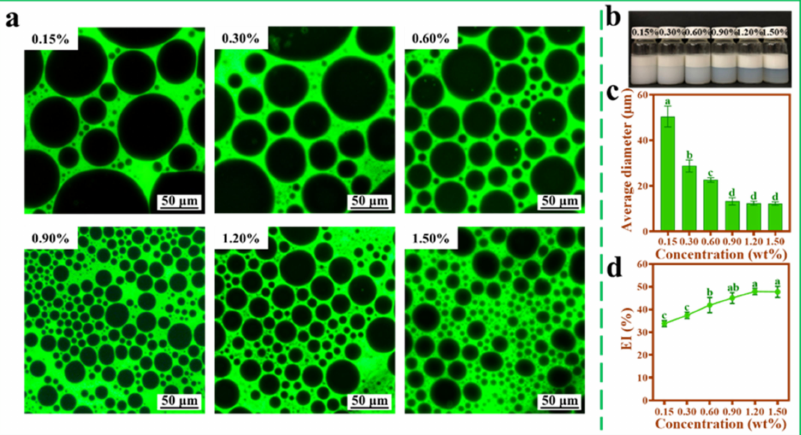
Figure 5. Inverted fluorescence microscopy images ( a ), photograph ( b ), average diameter ( c ), and EI% ( d ) of Pickering emulsions at different TOCNFs concentrations (0.15 wt%, 0.30 wt%, 0.60 wt%, 0.90 wt%, 1.20 wt%, and 1.50 wt%, pH = 7, ω (NaCl) = 0, 450 W). Different letters of a, b, c and d show significant